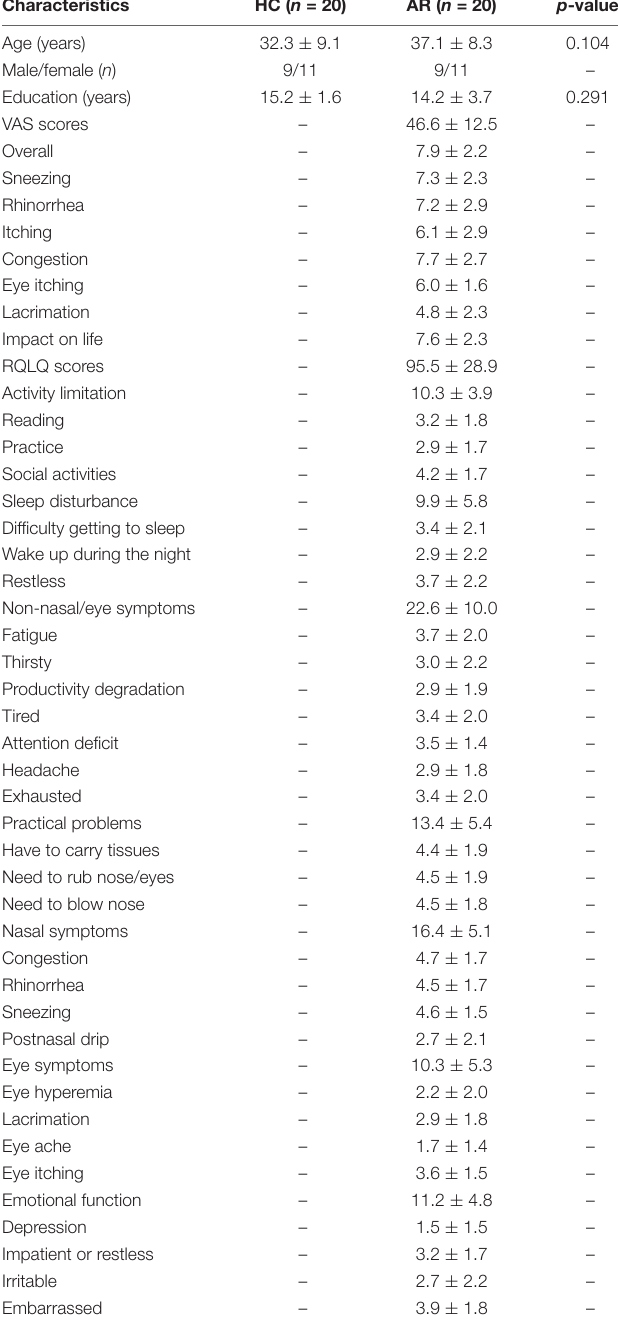
TABLE 1 | Demographic and clinical characteristics between allergic rhinitis (AR) patients and the healthy control (HC)